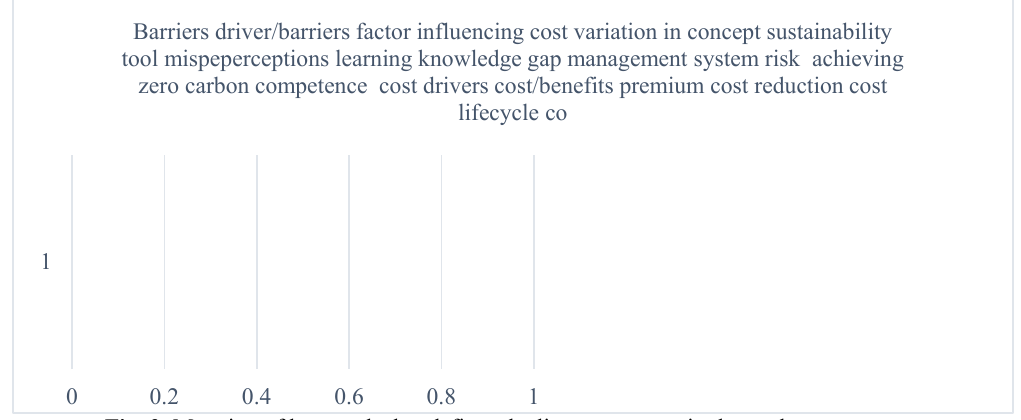
Fig. 3. Mapping of keywords that defines the literature scope in the